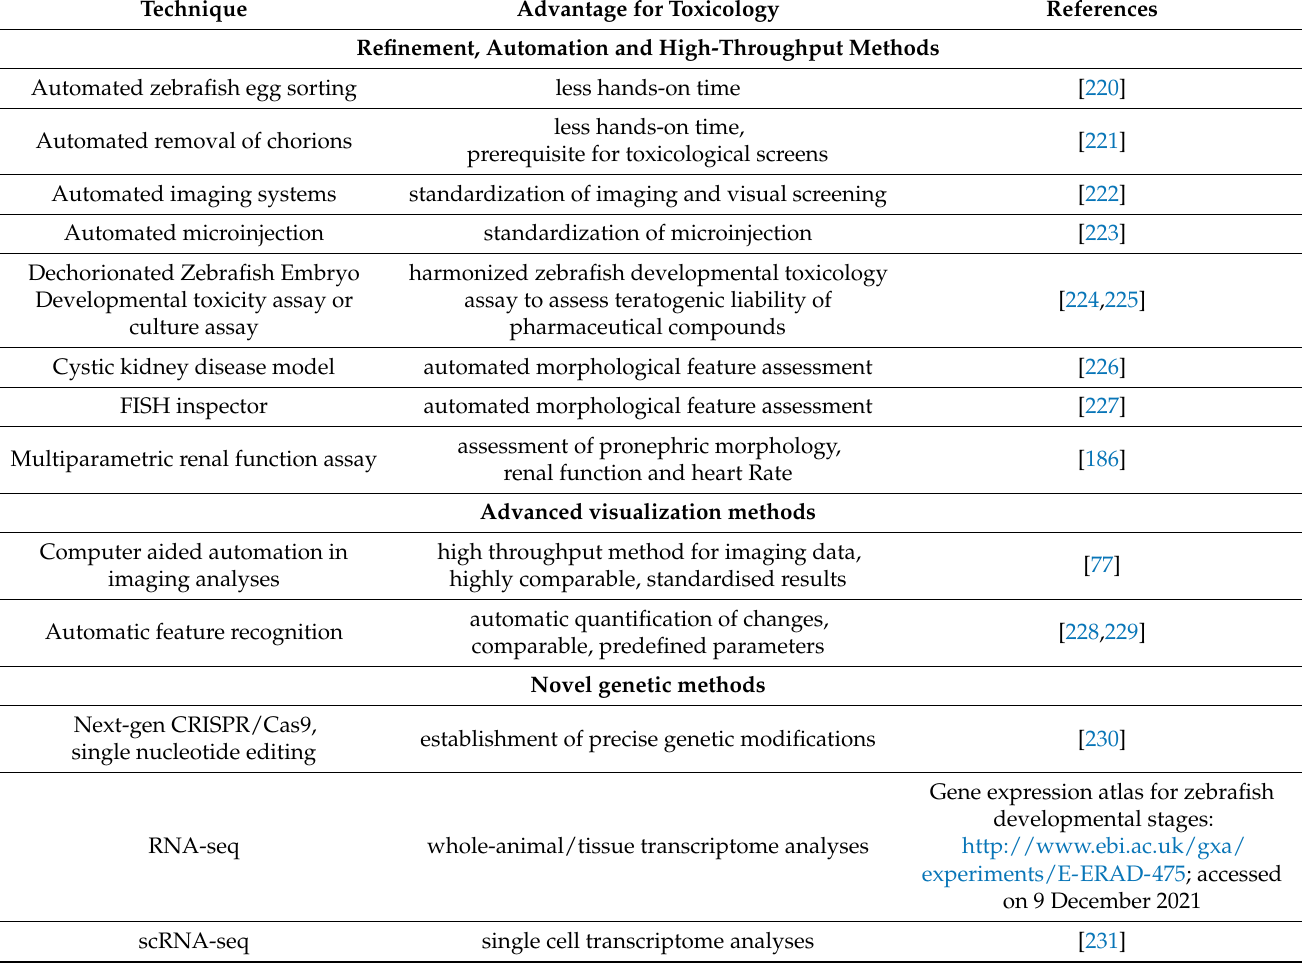
Table 3. Novel techniques enhancing toxicological investigation in